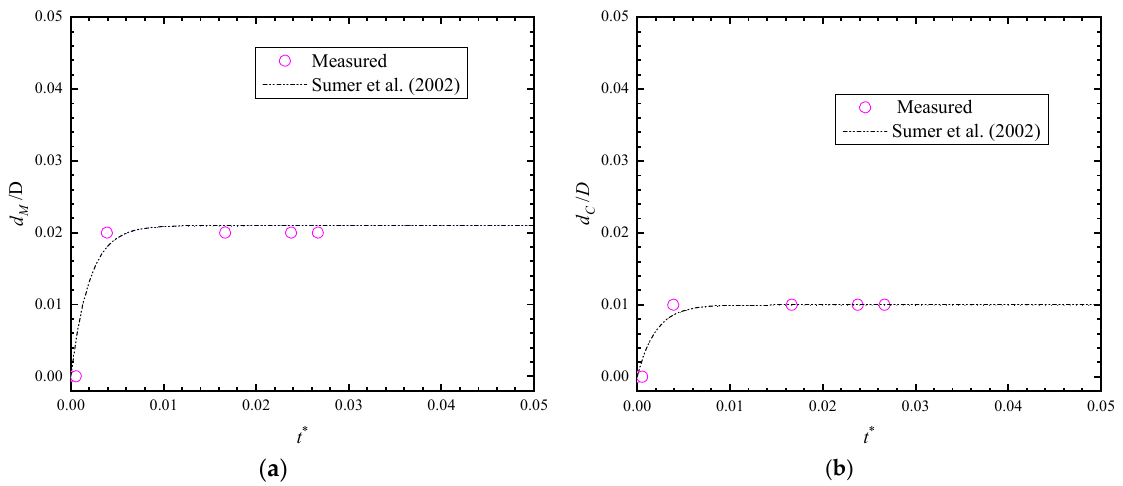
Figure 6. Non-dimensional scour depth evolutions for test 3. ( a ) Upstream corner scour depth evolution; ( b ) Center of upstream scour depth evolution.